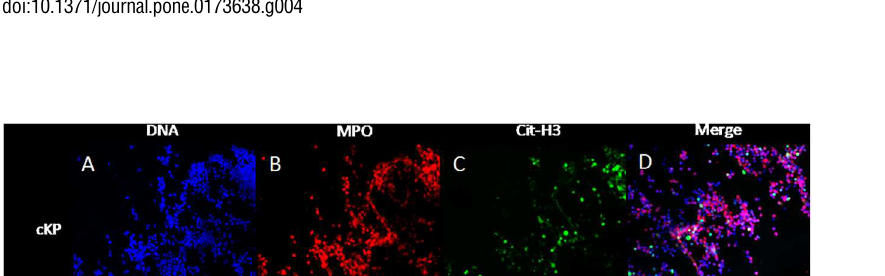
Fig 4. NETs under scanning electron microscopy. NETs inducedby PMA (A and B), cKP (3 isolates, C and D), and HvKP-K1 (3 isolates, E and F). More cKP (C) than HvKP-K1 (E) were trapped in NETs by magnification of 5K. The pores (indicated by white arrows) on the surface of cKP, but not on the surface of HvKP-K1 were observedby magnification of 20K (D and F). Bacteria were indicatedby black arrows.